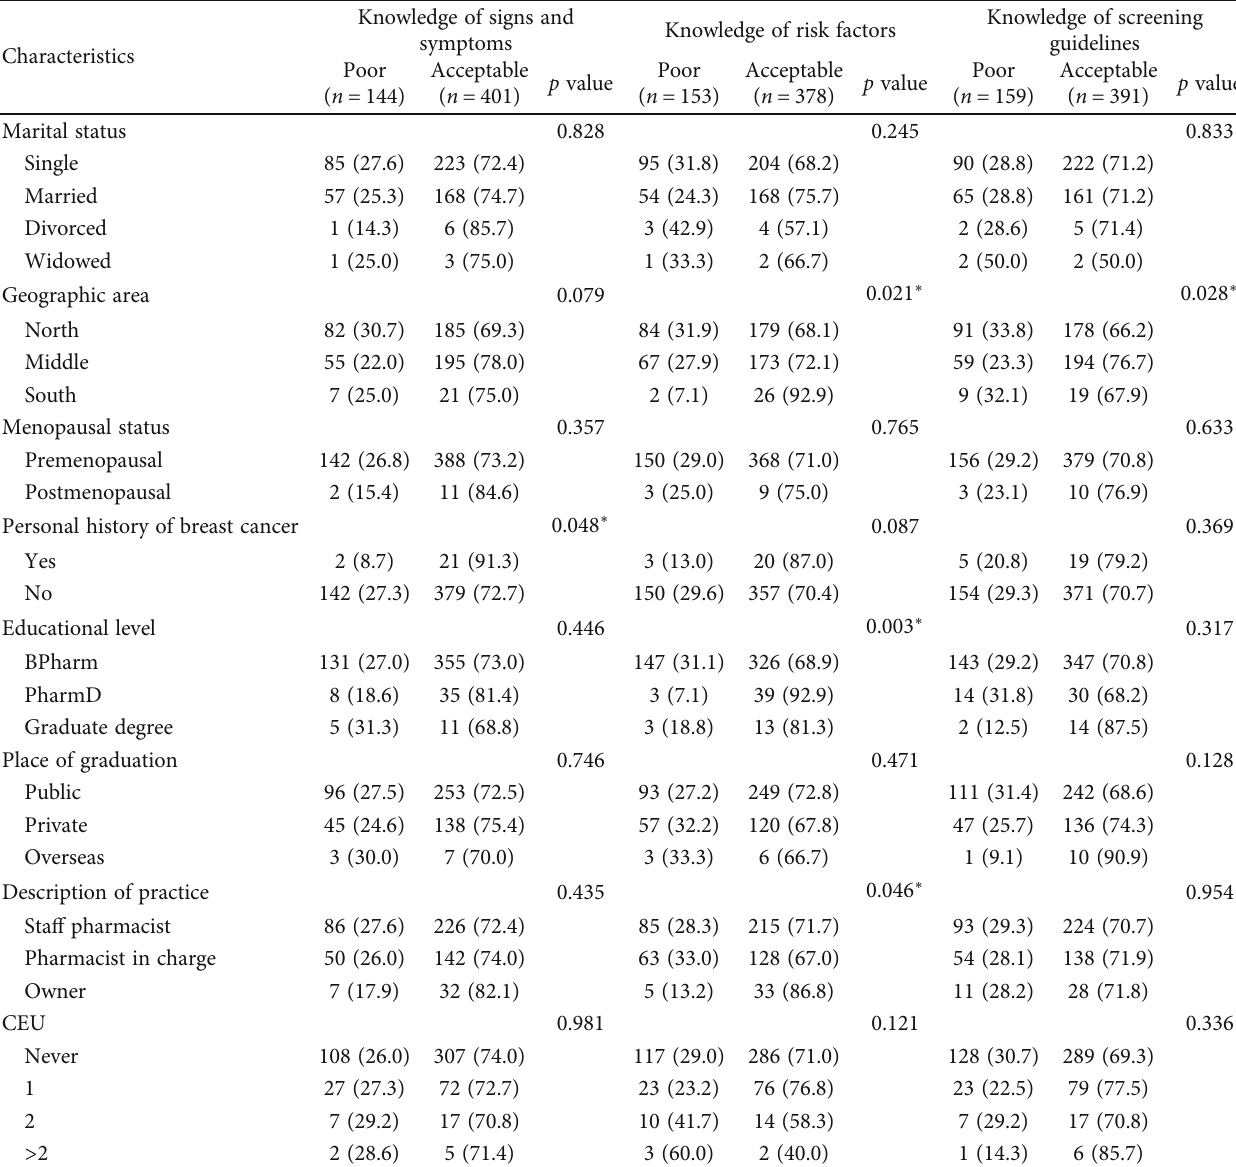
Table 4: Association of knowledge of breast cancer with demographic and practice characteristics among community pharmacists.